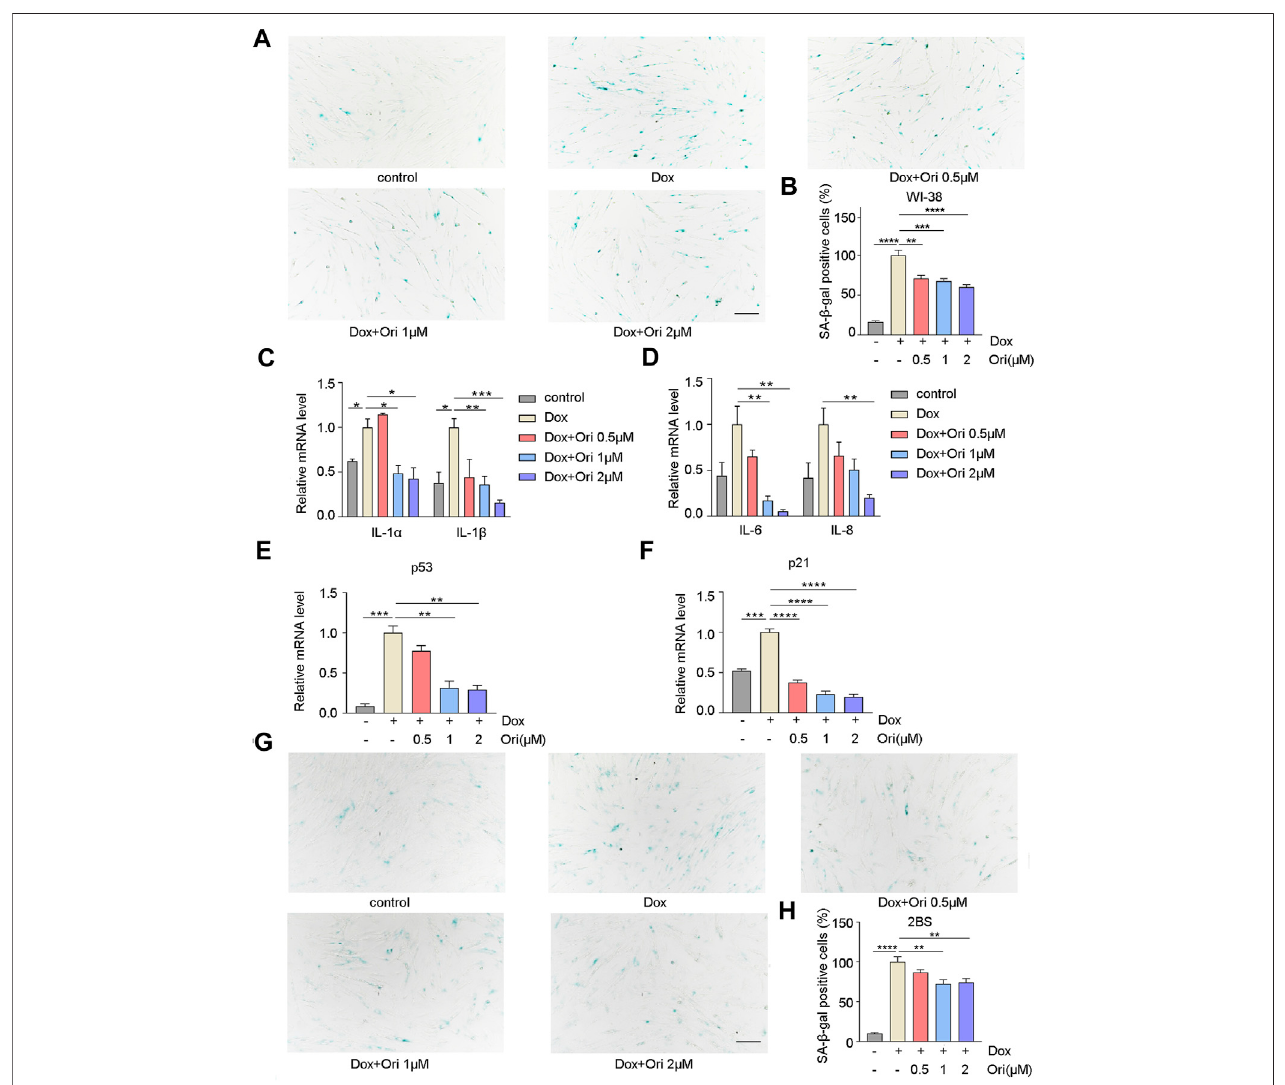
FIGURE 4 | Oridonin delays cell senescence induced by doxorubicin. 1 μ M doxorubicin-induced PD30 2BS or WI-38 cells for 12 h. (A) SA- β -gal staining of doxorubicin-inducedWI-38cellstreatedwith0.5,1,2 µMoridoninorDMSOcarrierfor48 h,Bar=200 µm. (B) QuantifytheproportionofSA- β -galpositivecellsinWI-38 cellstreatedwithdifferenttreatments. (C – D) Treatmentofdoxorubicin-inducedWI-38cellswith0.5,1,2 µMoridoninorDMSOcarriersfor36 hofIL-1 α ,IL-1 β ,IL-6,and IL-8mRNAlevels. (E – F) Thechangesofp53andp21mRNAlevelsinWI-38cellsinducedbydoxorubicinweretreatedwith0.5,1,2 µMoridoninorDMSOfor36 h. (G) SA- β -galstainingofdoxorubicin-induced2BScellstreatedwith0.5,1,2 µMoridoninorDMSOcarriersfor48 h,Bar=200 µm. (H) Quanti fi cationofSA- β -galpositive cell ratein2BScellsofdifferenttreatments( A − H , n ≥ 3foreach group). Datarepresentthemean±SEM. one-wayANOVA orStudent ’ st-testdetermined p values. (* p < 0.05, ** p < 0.01, *** p < 0.001, **** p <